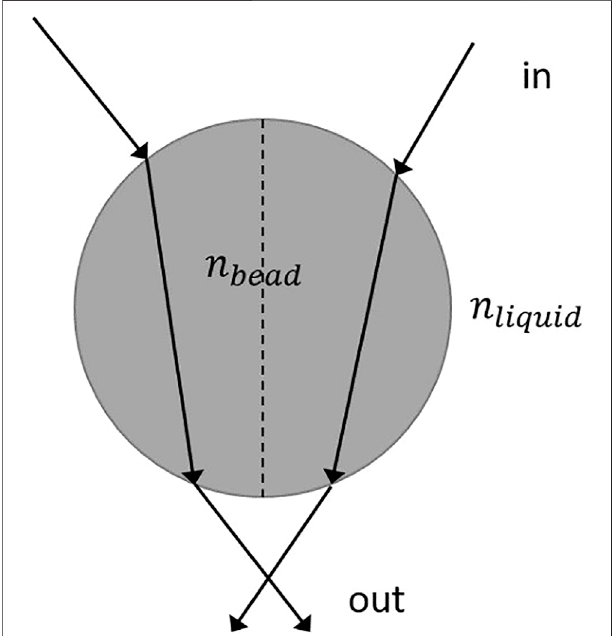
FIGURE 1 | Optical trapping method used by